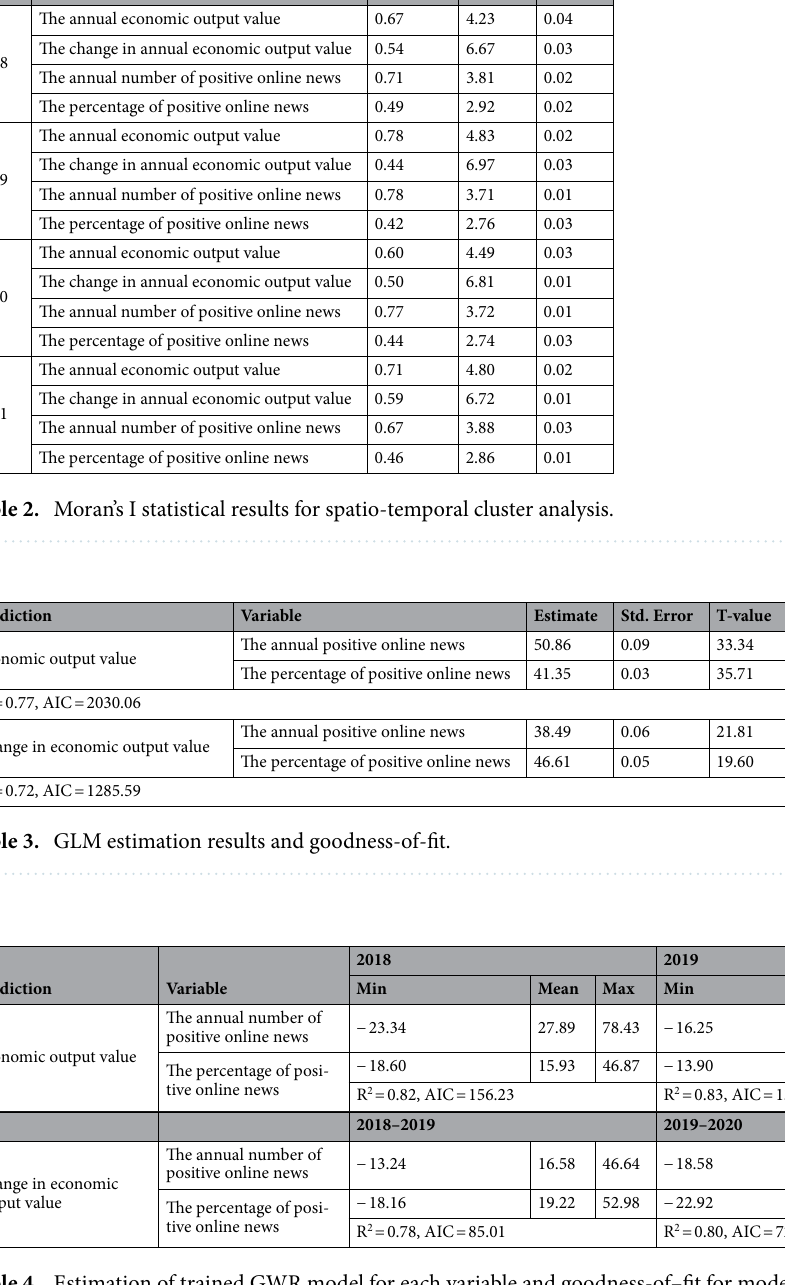
Table 4. Estimation of trained GWR model for each variable and goodness-of–fit for model training period.